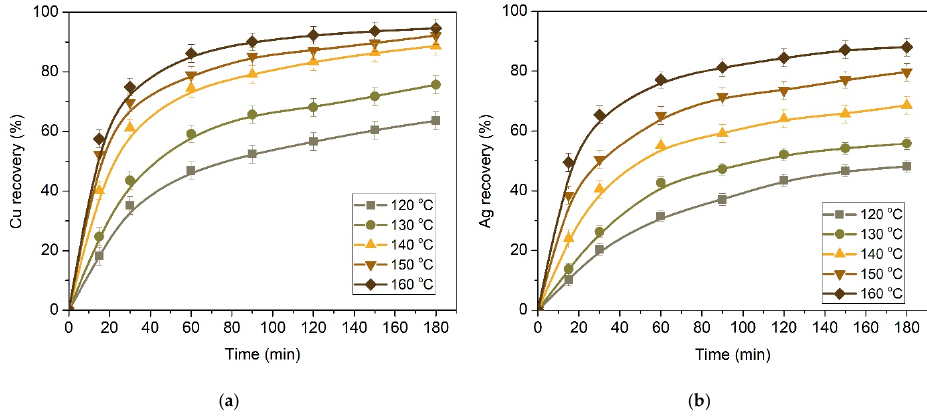
Figure 6. Dependence of the recovery of copper ( a ) and silver ( b ) into the solution on the temperature and duration of leaching of desilicated concentrate.